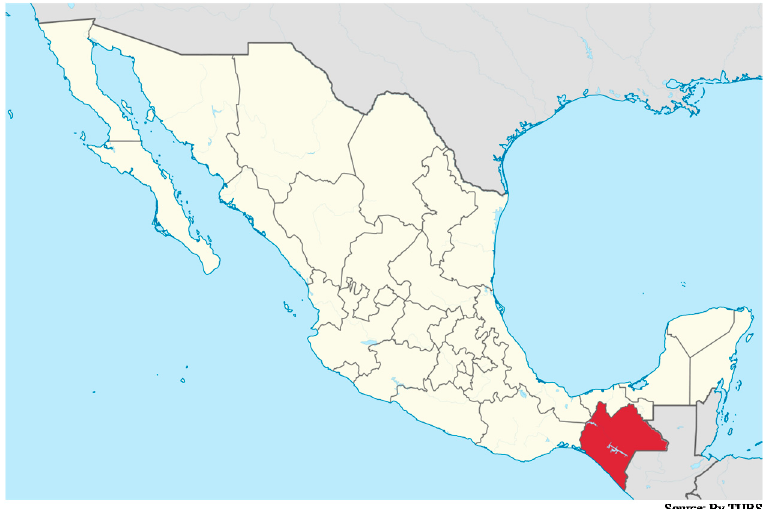
Figure 2. Map of the State of Chiapas, Mexico .